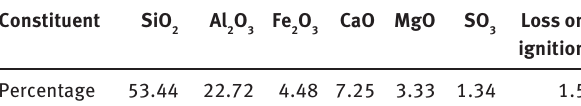
Table 1 Chemical composition of fly ash in weight percentage.